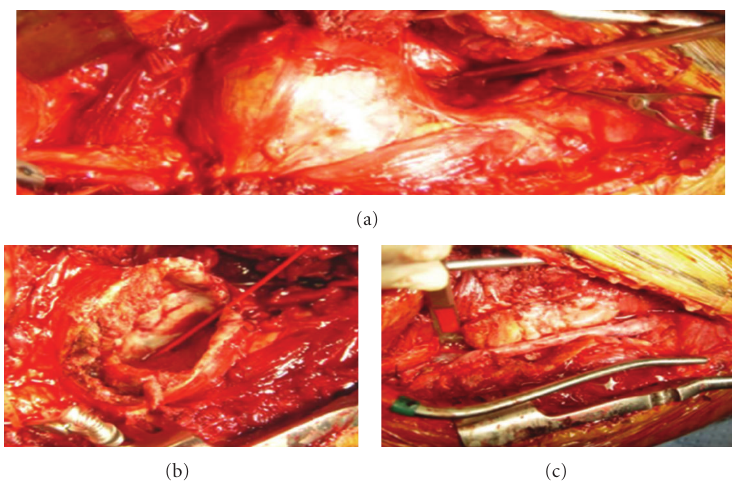
Figure 3: Intraoperative image of the true giant posterior tibial artery aneurysm. On the left, the aneurysm is opened with a large thrombus. On the right, resection and interposition of a reversed saphenous vein